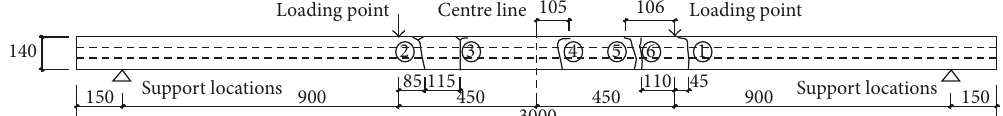
Figure 25: Cracking location (mm).